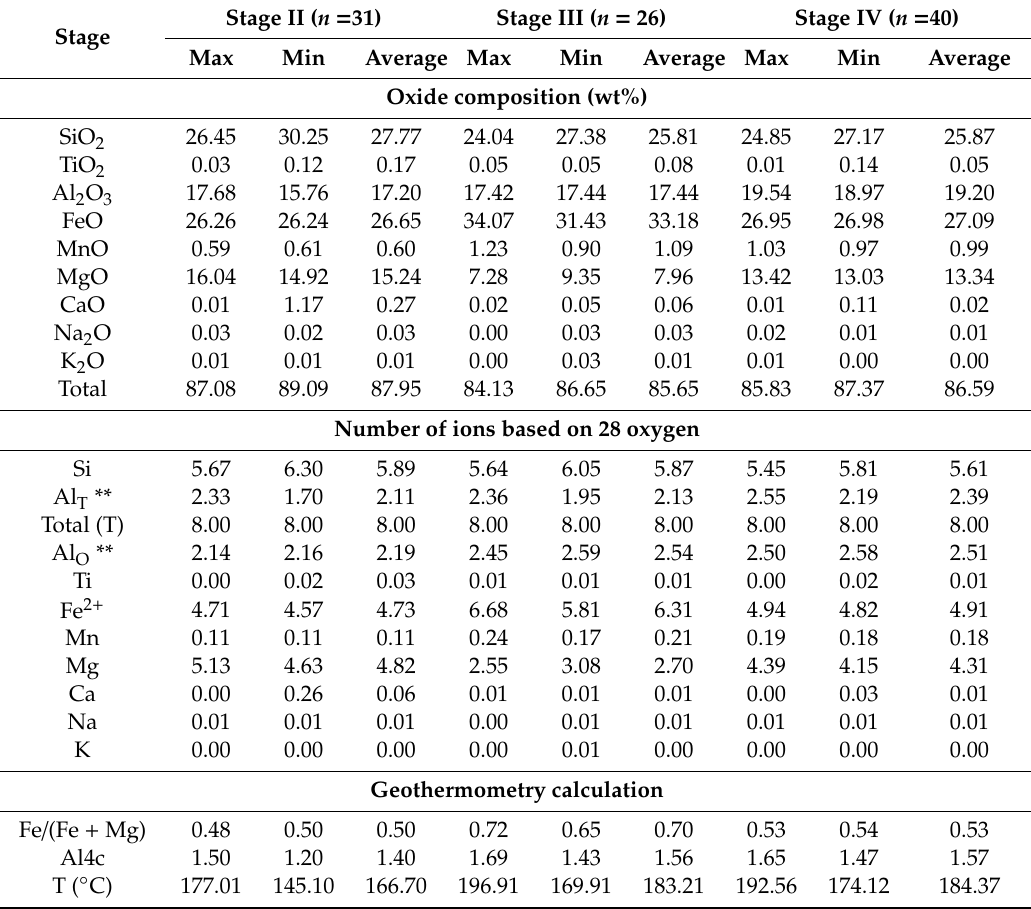
Table 3. Major element analysis data of chlorites from Sangdong W-deposit (in brief) *. Stage II ( n = 31) Stage III ( n = Stage